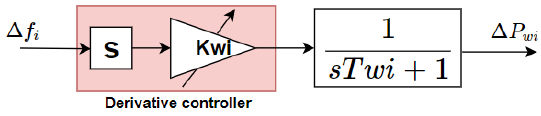
Figure 8. Derivative control loop for